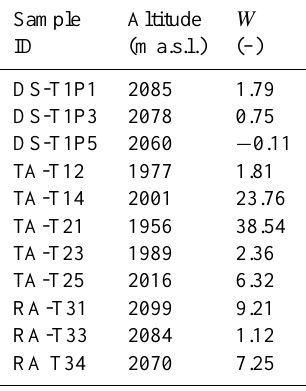
Table 2. Calculated W (winter factor). Negative values correspond to sedimentation rates. DS: defense structures area; TA: track area; RA: release